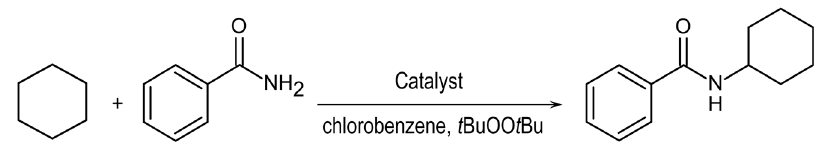
Figure 13. Catalytic amidation of cyclohexane, catalysed by 1 .